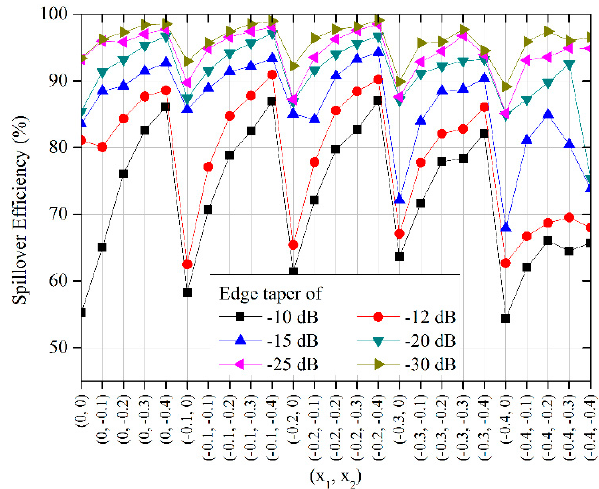
Figure 7. Comparison of directivity (at 140 GHz) for horn antennas with 2 and 3 node points.